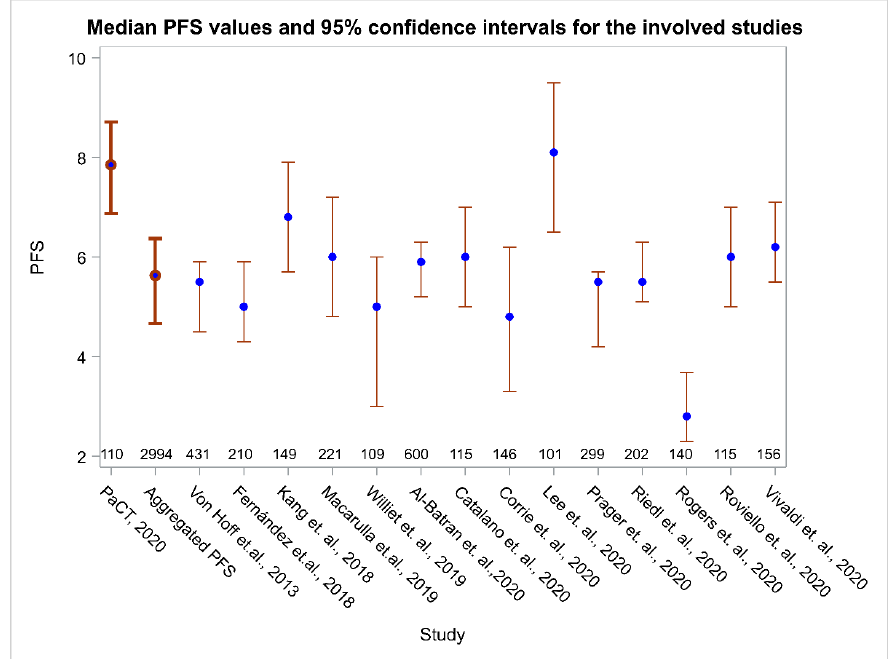
Figure 3. Median PFS and 95% CI for this study (the PaCT study), for the aggregated PFS (weighted PFS) and for the 14 individual reference studies. Numbers above the horizontal axis indicate the number of patients in each study.